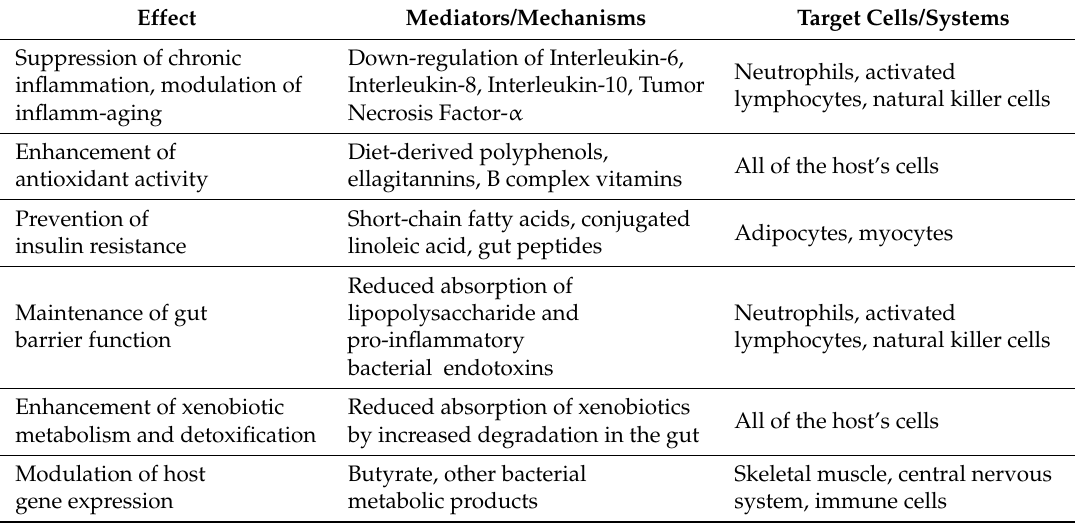
Table 1. Overview of the main effects of a healthy gut microbiota on the physiologic processes involved in healthy, active